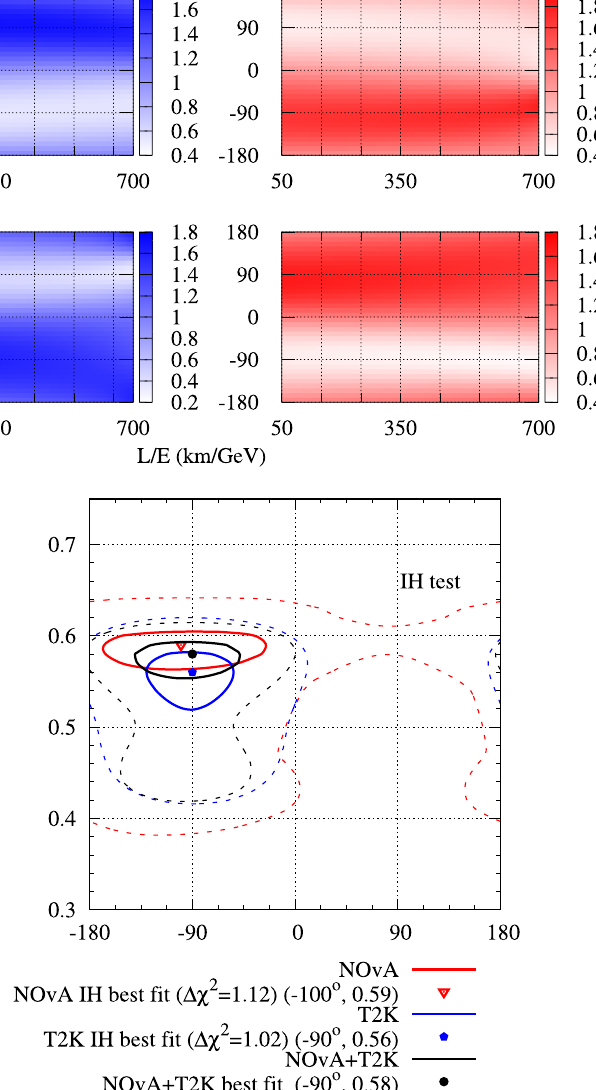
Fig. 8 Ratio of the LIV to standard oscillation probabilities as a function of L / E and δ CP . The reference energy E = 0 . 7 GeV has been fixed to the T2K flux peak energy. For this peak energy and T2K baseline, L / E = 421 km/GeV. The upper (lower) panel shows the ratio for NH (IH), the left (right) panel shows it for neutrino (anti-neutrino). | a e μ | and | a e τ | have been fixed at 2 × 10 − 23 GeV each and we have set φ